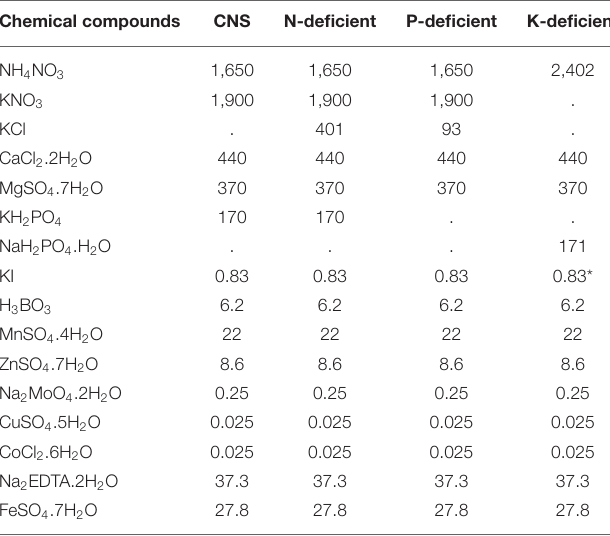
TABLE 1 | Chemical contents (milligrams) of complete nutrient solution (CNS) and those deficient in nitrogen (N), phosphorus (P) and potassium (K). Chemical